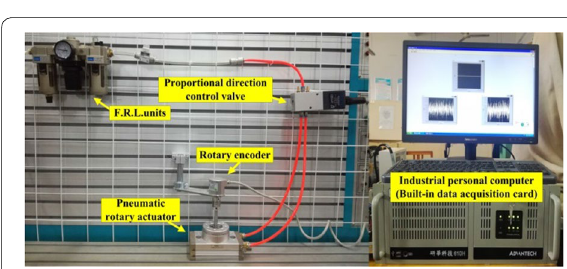
Figure 2 Experimental diagram of the pneumatic rotary servo-control system